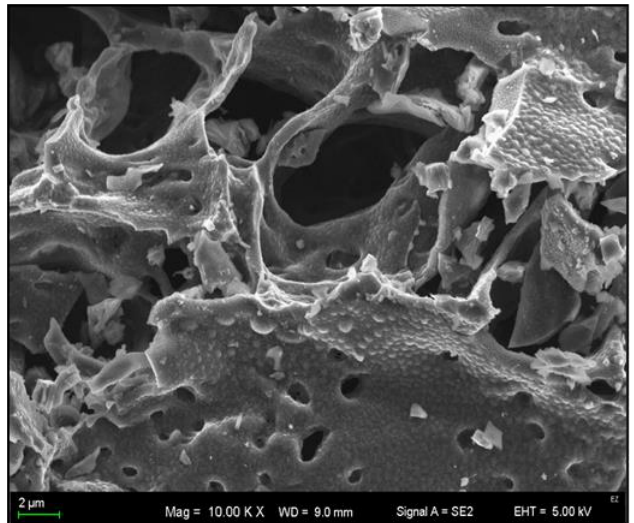
Figure 1. SEM image of the biochar porosity.